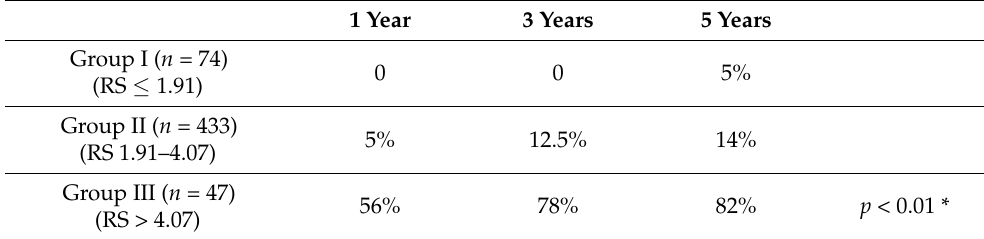
Table 5. Cumulative incidence rates of HCC recurrence based on range of risk score (RS).